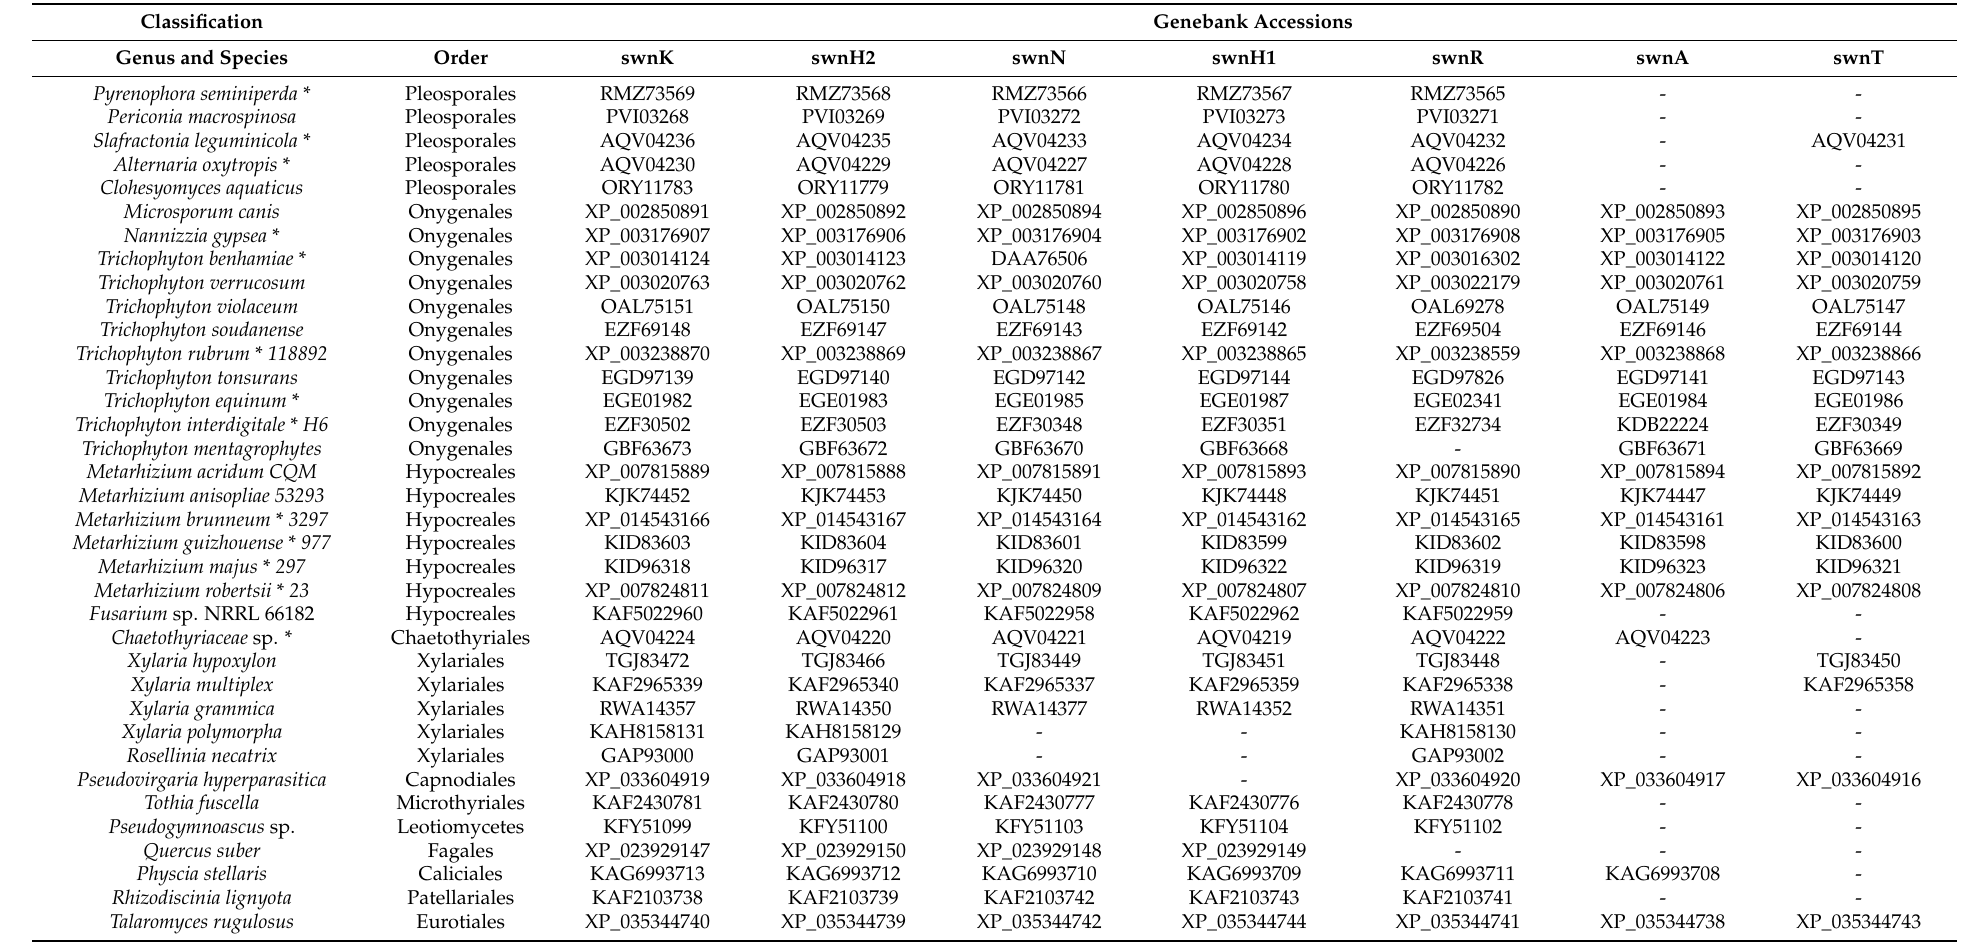
Table 1. SWN protein homologues and Genebank accession numbers. (-) indicates the absence of that gene in the NCBI database. (*) indicates that the organism has been reported to produce swainsonine (Cook et al.,